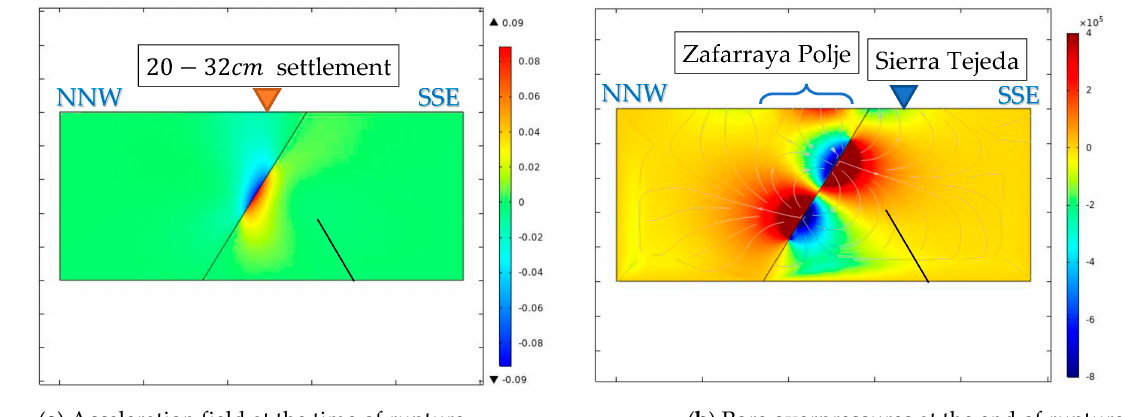
Figure 8. Results from the dynamic analysis: ( a ) Total acceleration field (m/s 2 ); ( b ) Maximum pore overpressure ( Pa ) induced by the earthquake. White lines represent the flow trajectories. Abscissae represent the fault line ( m ), starting from its bottom.